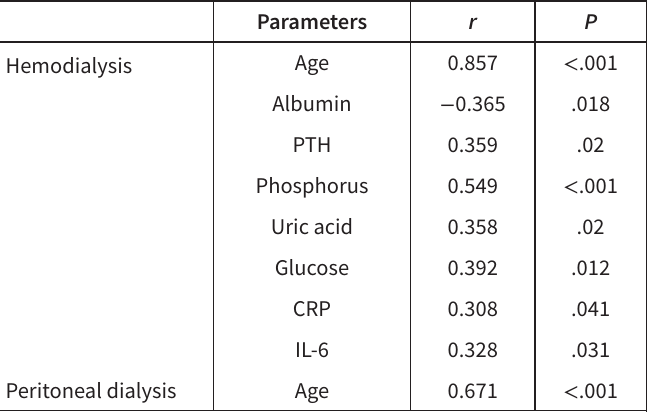
Table 2. Correlation Analysis Between Carotid Intima Media Thickness and Parameters in Dialysis Patients